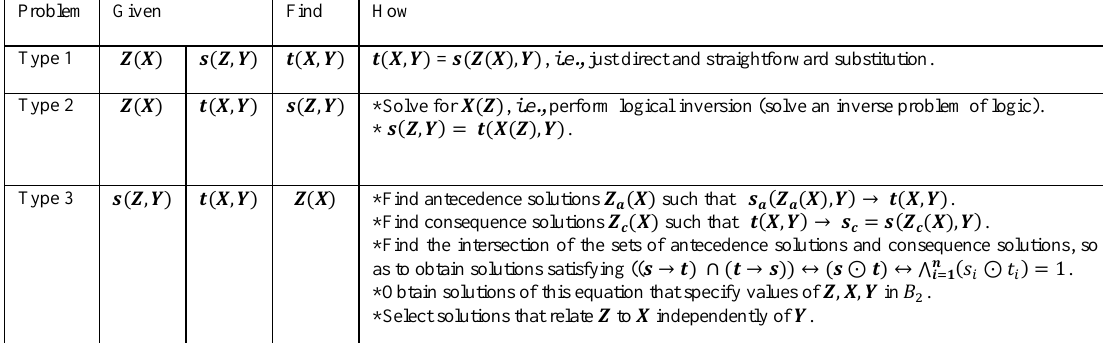
Table 1. Taxonomy of Ledley’s elementary problems of digital